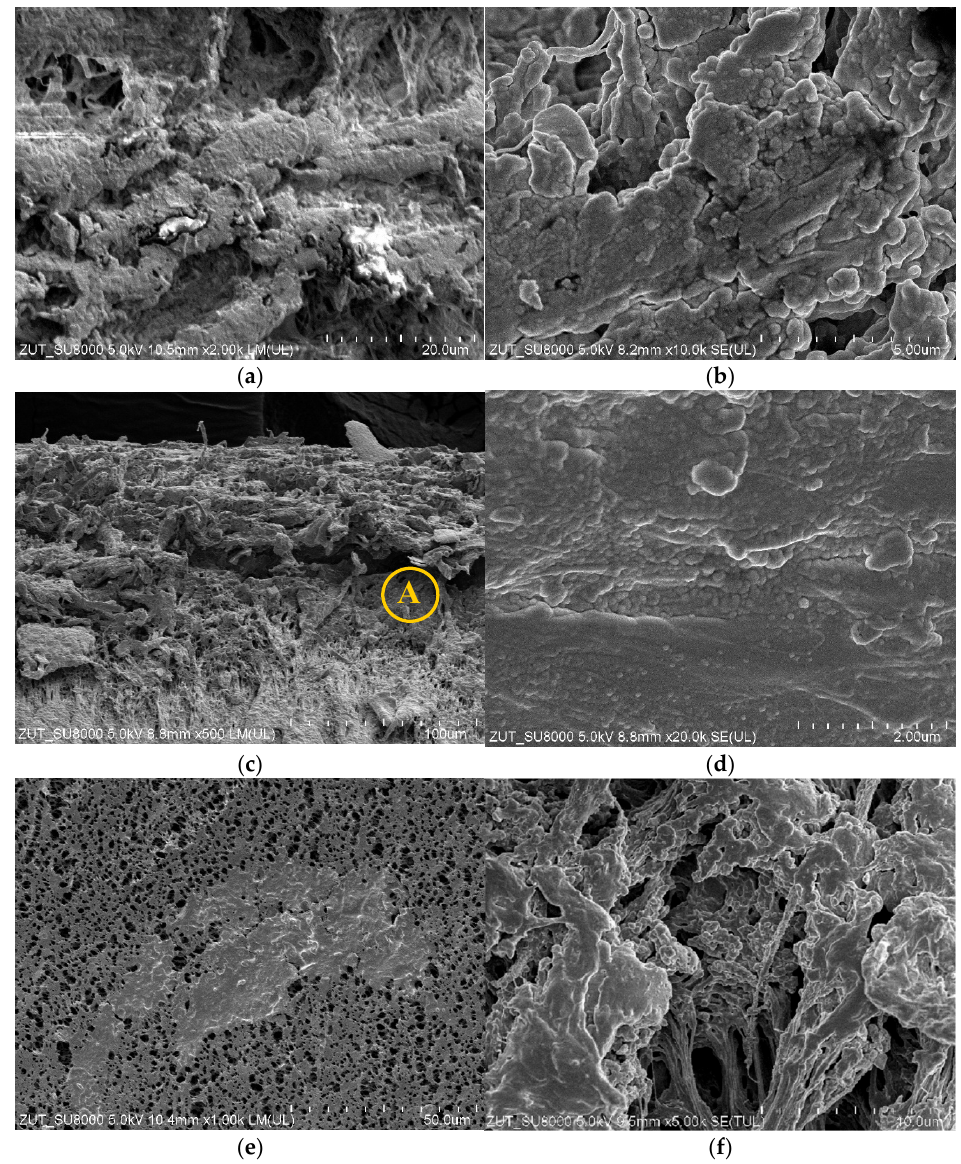
Figure 16. SEM images of the membranes used. Module SMD ‐ S6 ‐ 1: ( a ) external surface; ( b ) magnified (x10k) external surface; ( c ) cross ‐ section; ( d ) the area A shown in Figure 16c magnified (x20k); ( e ) internal surface. Module SMD ‐ V8: ( f ) external surface.